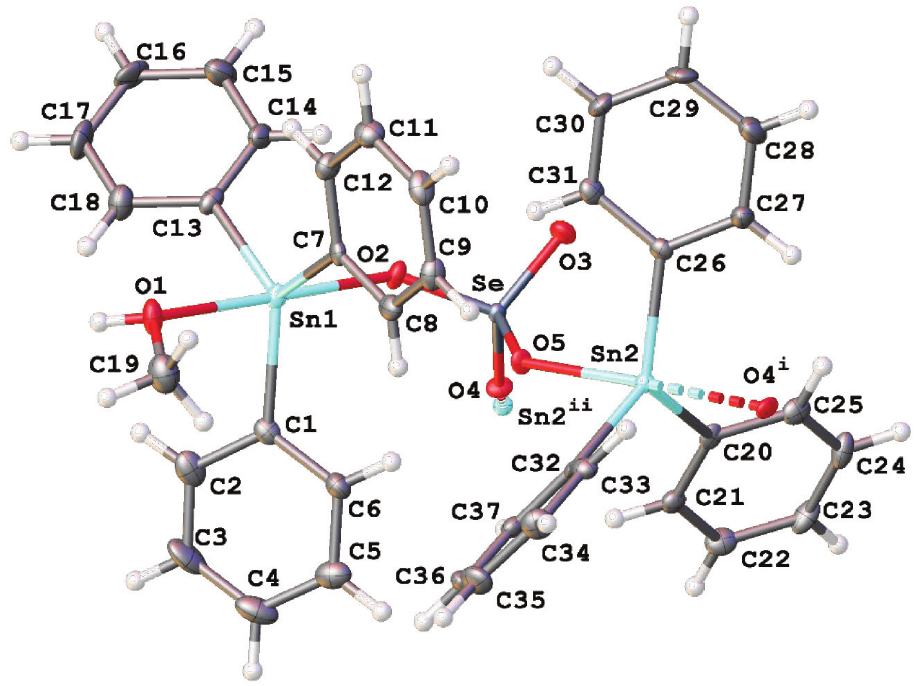
Figure 1: Crystal structure of 1 showing 50% probability ellipsoids and the crystallographic numbering scheme (Olex2 view). Selected bond lengths and angles [Å, °]: Sn1-O1 2.320(3), Sn1-O2 2.213(3), Sn1-C1 2.119(4), Sn1-C7 2.123(4), Sn1-C13 2.119(4), Sn2-O5 2.230(2), Sn2-O4 i 2.285(2), Sn2-C20 2.122(4), Sn2-C26 2.119(4), Sn2-C32 2.130(4), Se-O2 1.650(3), Se-O3 1.616(3), Se-O4 1.636(3), Se-O5 1.651(2), C19-O1 1.464(5); C13-Sn1-C7 117.07(16), C1-Sn1-C7 120.93(14), C1-Sn1-C13 121.54(14), C26-Sn2-C32 121.34(15), C26-Sn2-C20 119.84(15), C20-